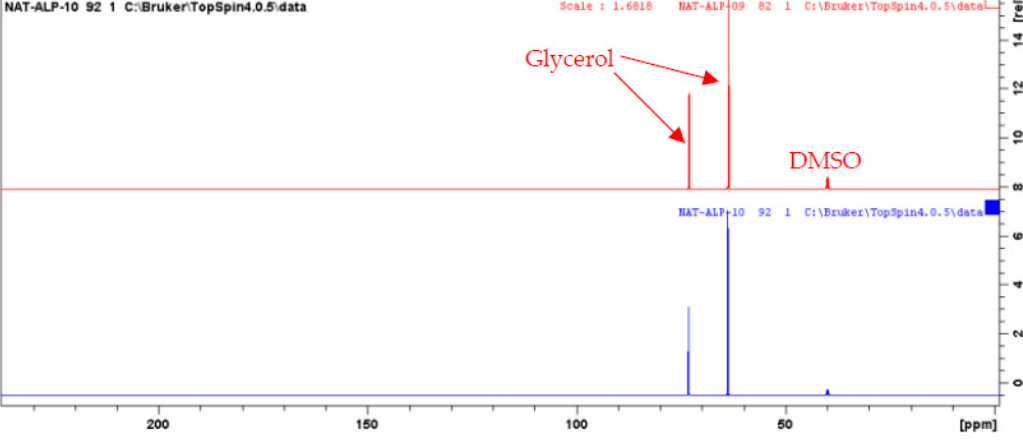
Figure 2. 13 C NMR spectra of CPC fractions F09 and F10.